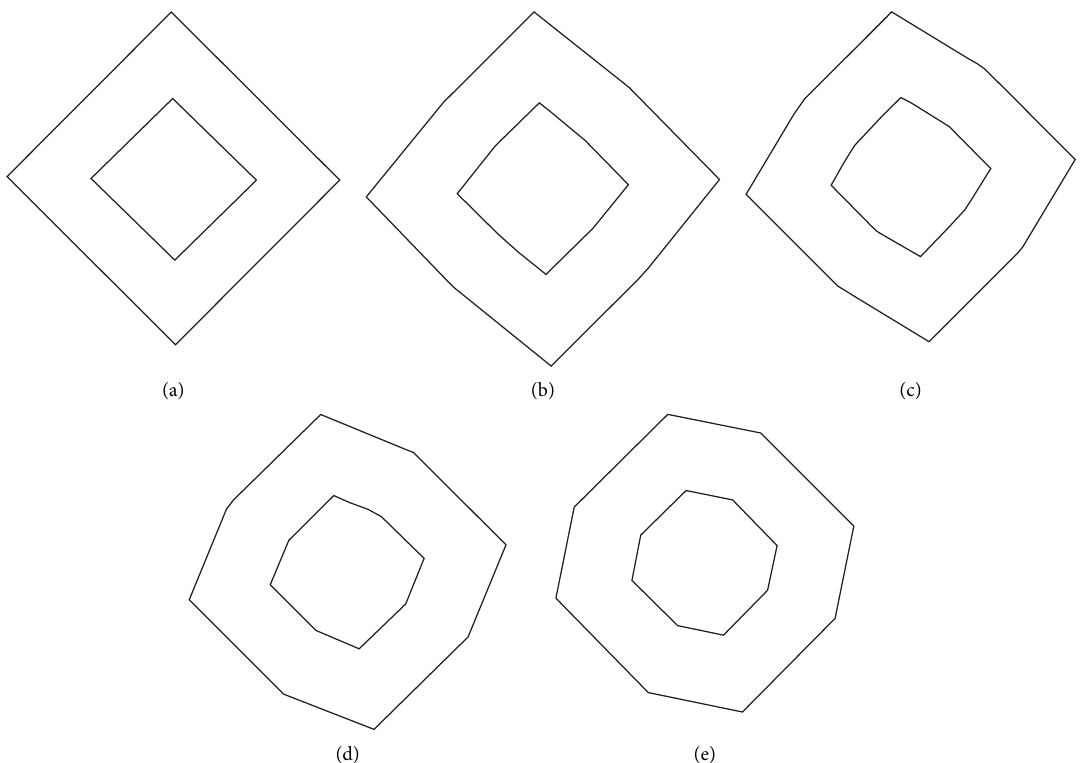
Figure 5: Blended shapes: (a) t � 0, (b) t � 0.1, (c) t � 0.2, (d) t � 0.3, and (e) t � 0.4.